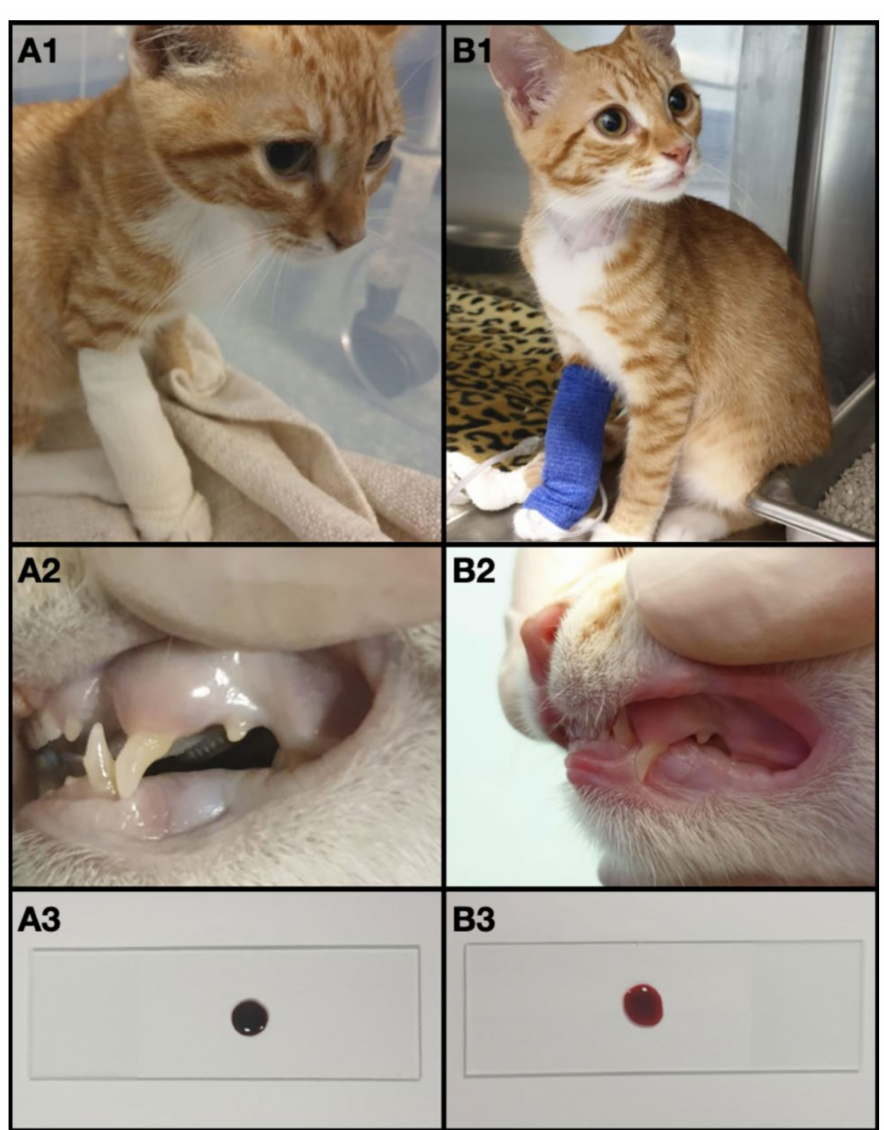
Figure 1. ( A1 ) the kitten at admission. ( A2 ) Cyanotic oral mucous membranes at admission. ( A3 ) blood drop at admission. ( B1 ) the kitten three hours after methylene blue administration. ( B2 ) pink oral mucous membranes three hours after methylene blue administration. ( B3 ) blood drop three hours after methylene blue